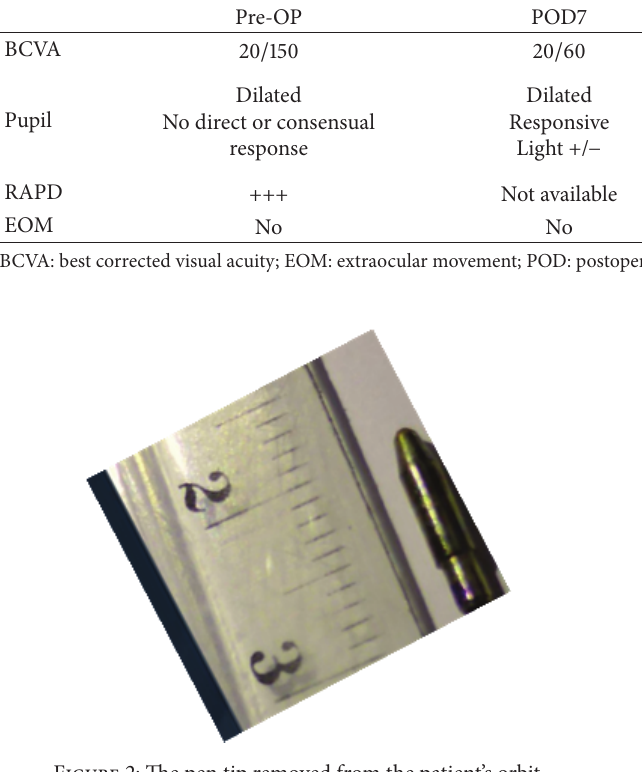
Figure 2: The pen tip removed from the patient’s orbit.